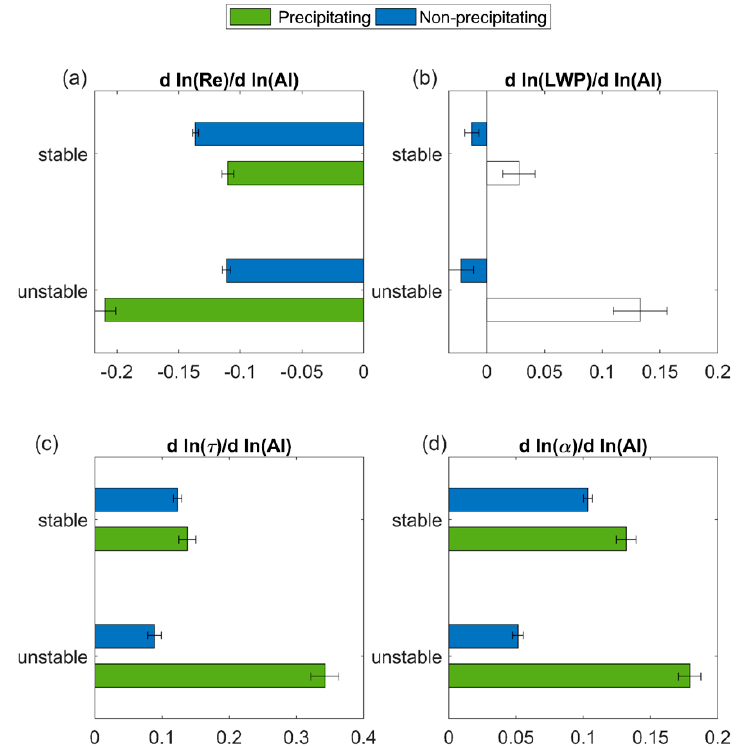
Figure 8. The cloud susceptibility to aerosol index (AI) under stable and unstable conditions. The cloud parameters were: ( a ) Cloud droplet effective radius (Re), ( b ) Cloud liquid water path (LWP), ( c ) Cloud optical depth ( τ ), and ( d ) Cloud albedo. The threshold value for the stable and unstable conditions was defined as NSS < 25th percentile and NSS > 75th percentile, respectively. Response for precipitating and non-precipitating clouds are shown in green and blue, respectively. All the filled bars are statistically significant at a 95% significance level. The error bars were calculated based on the standard error of the regression slope.